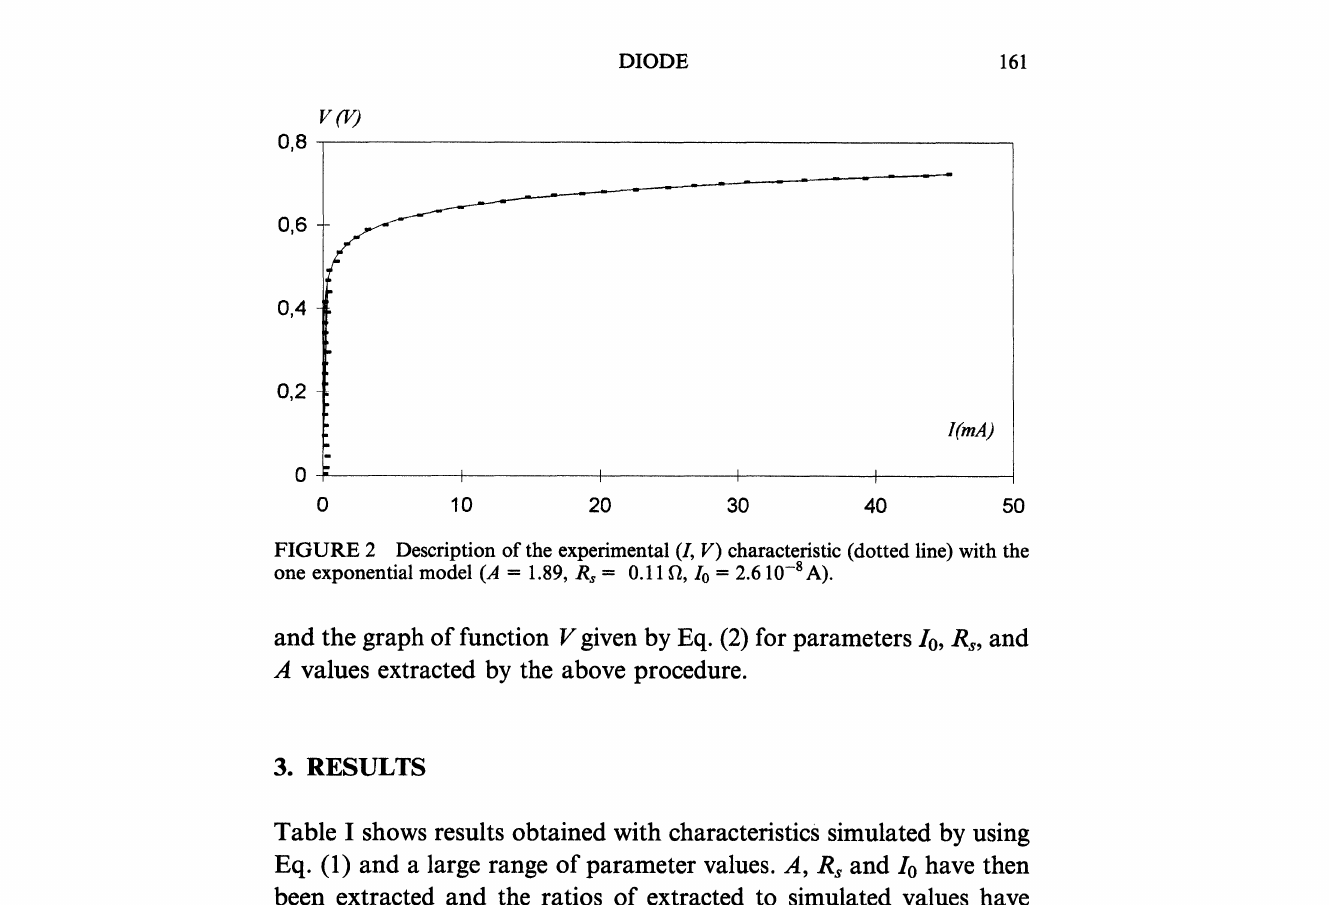
FIGURE 2 Description of the experimental (L V) characteristic (dotted line) with the one exponential model (A 1.89, R 0.11 fl, I0 2.610 -s A).